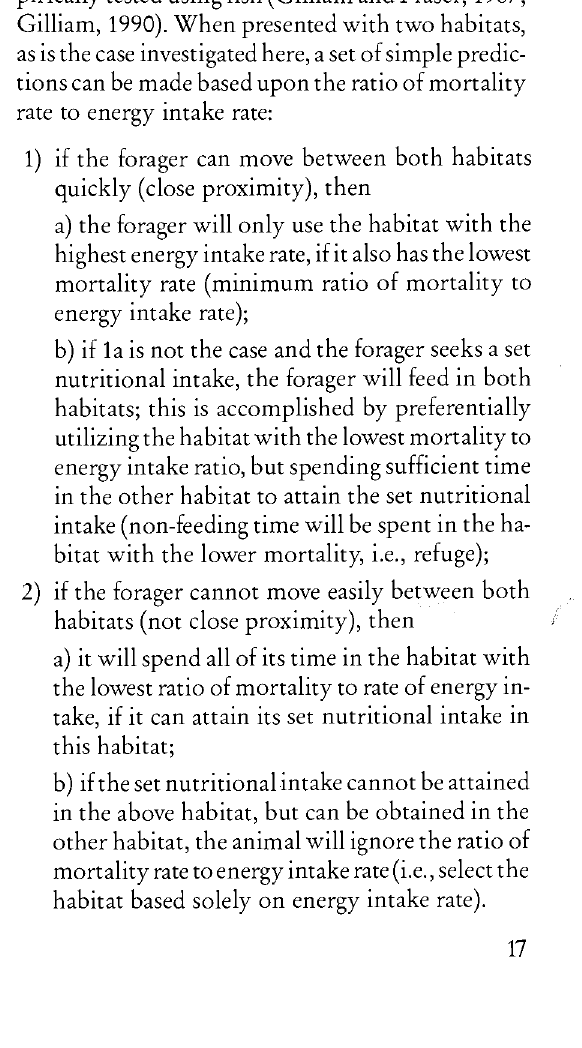
Fig. 4. The comparison between the energy intake rates in July for caribou/reindeer in two habitats, where one habitat (LM: lake margin) has higher biting in sect abundances. The lake margin energy intake rate must fall below the horizontal line before the other habitat (HC: high-centre polygon) will be used. This occurs at moderate and worse levels of insect harassment in the lake margin habitat.